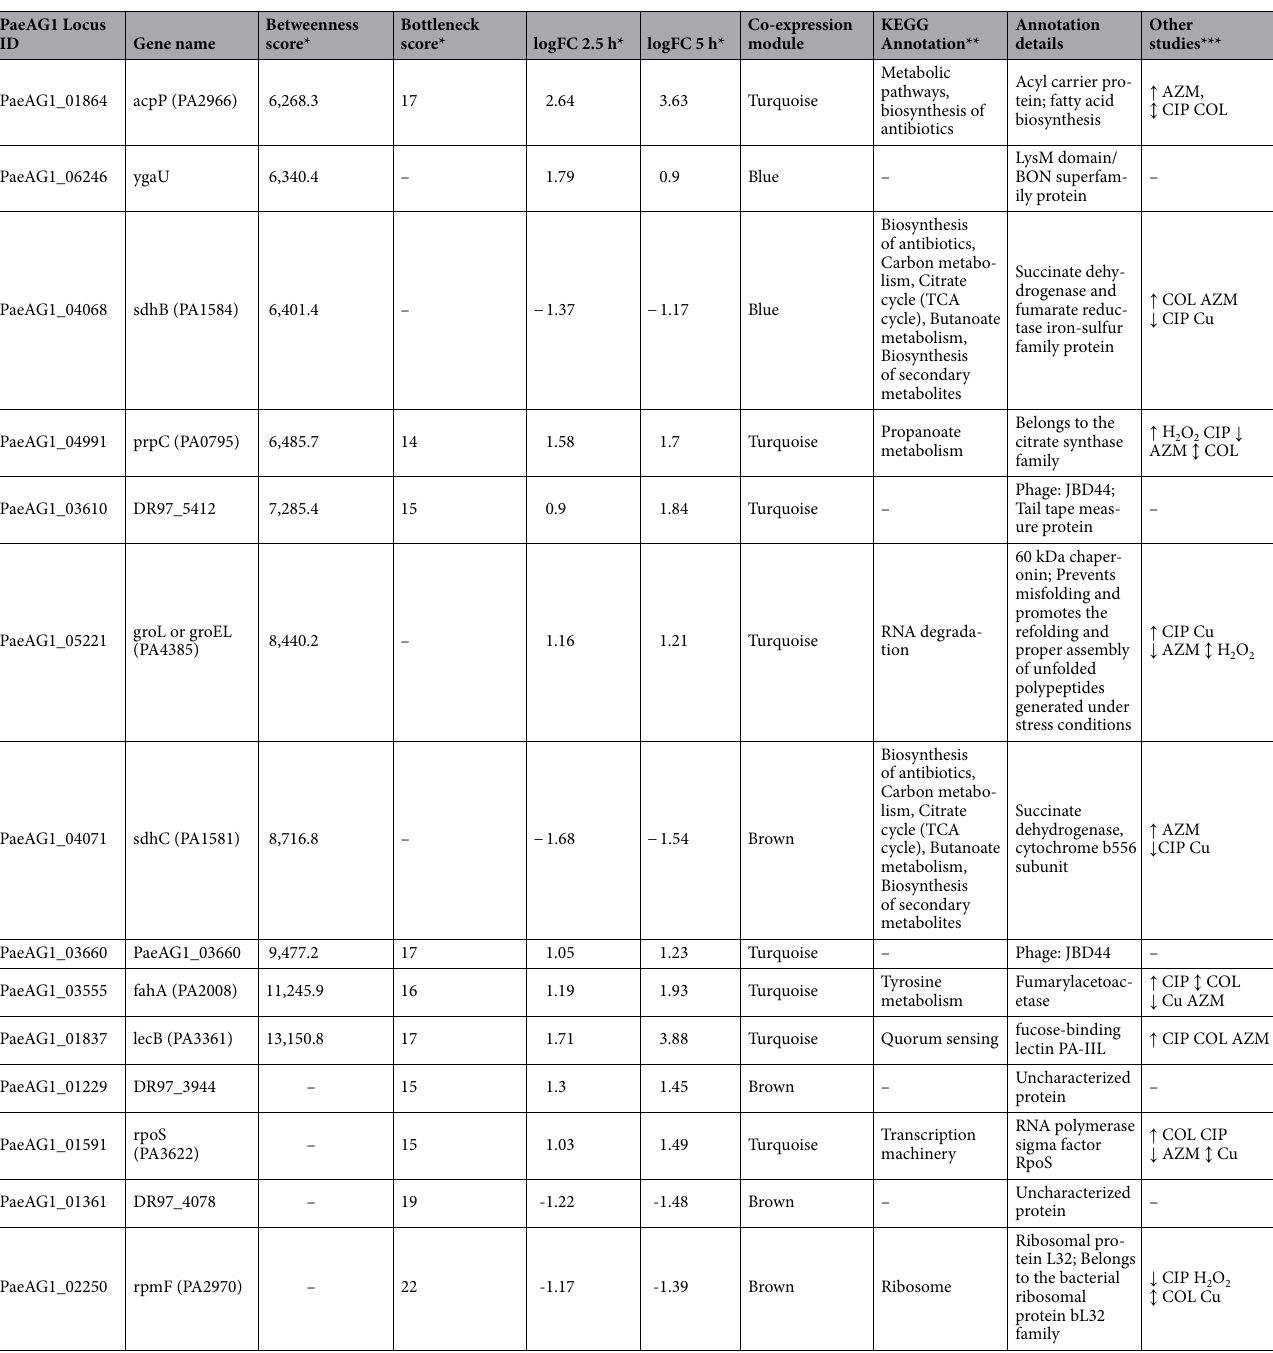
Table 4. Characterization of hub genes in the DEGs network of PaeAG1 after treatment with ciplofloxacin. *Cases with gray numbers refer to genes which were no selected as a DEG at that time (logFC and adjusted p -value). **Cases with “-” refer to no annotation information. ***Results from other studies: ↑ up-regulated, ↓ down-regulated, ↕ variable regulation or “– “ no information. All results from GEO-NCBI according to stress conditions: Cu (copper) from (Teitzel et al., 2006), CIP (ciprofloxacin) from (Cirz, O’Neill, Hammond, Head, & Romesberg, 2006), COL (colistin) from (Cummins, Reen, Baysse, Mooij, & O’Gara, 2009), AZM (Azithromycin) from (Kai et al., 2009) and H 2 O 2 (hydrogen peroxide) from (Chang, Small, Toghrol, & Bentley,